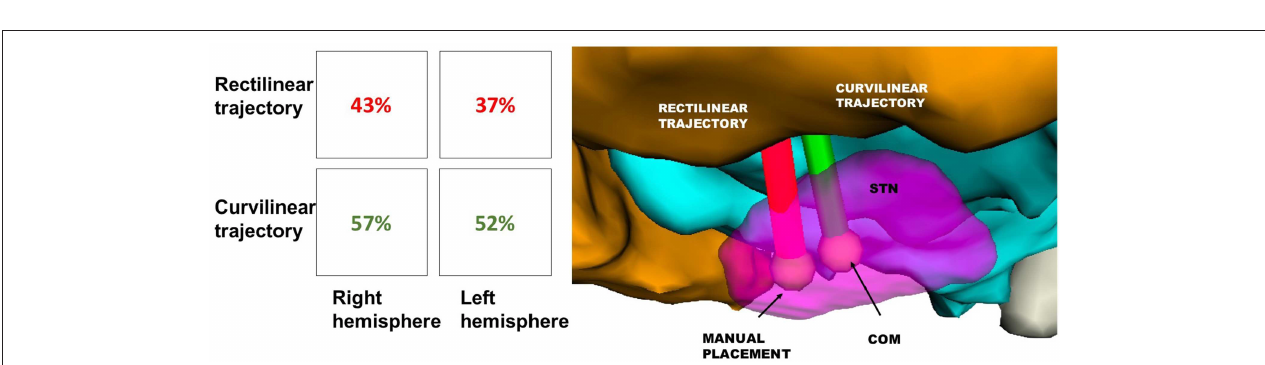
FIGURE 6 | (A) The 3D Reconstruction of the most critical obstacles is shown. (B) Comparison between RTs and CTs, in terms of the mean value of the d min calculated over the best trajectory of all the EP i of all the subjects, from each AO separately, of left(I) and right (II) hemisphere. (C) Comparison between RTs and CTs, reported for 9647 subject left hemisphere, in terms of the mean value of d min , calculated over the best trajectory of all the EP i of the subject, from each AO separately (I). The illustrative scene of 9647 single-case scenario has been taken from 3D Slicer 4.7.0 (II). (D) Comparison between RTs and CTs, reported for 5960 subject left hemisphere, in terms of the mean value of d min , calculated over the best trajectory of all the EP i of the subject, from each AO separately (I). The illustrative scene of 5960 single-case scenario has been taken from 3D Slicer 4.7.0 (II).